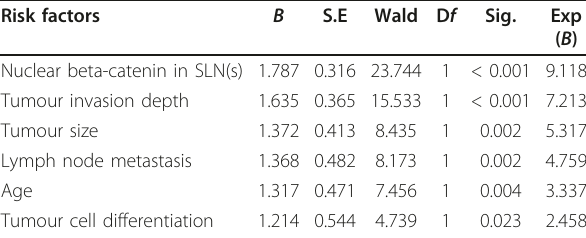
Table 4 Variables in the equation for the multivariate logistic regression